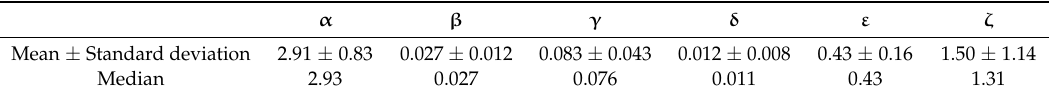
Table 1. Posterior distributions of parameters ( α , β , γ , δ , ε , and ζ ) in Equation (1) Ln( cum.Emi. ) = α + β × inun.crop − γ × noninun.fallow − δ × inun.fallow + ε × straw − ζ × sulfate fitted by hierarchical